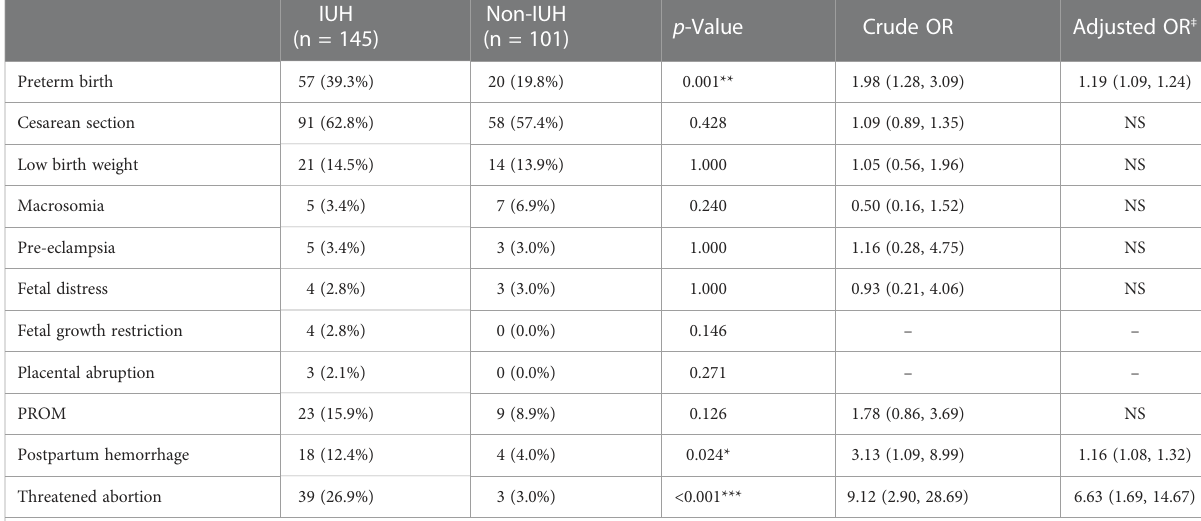
TABLE 2 Incidence and risk of pregnancy complications in VTS patients with and without intrauterine